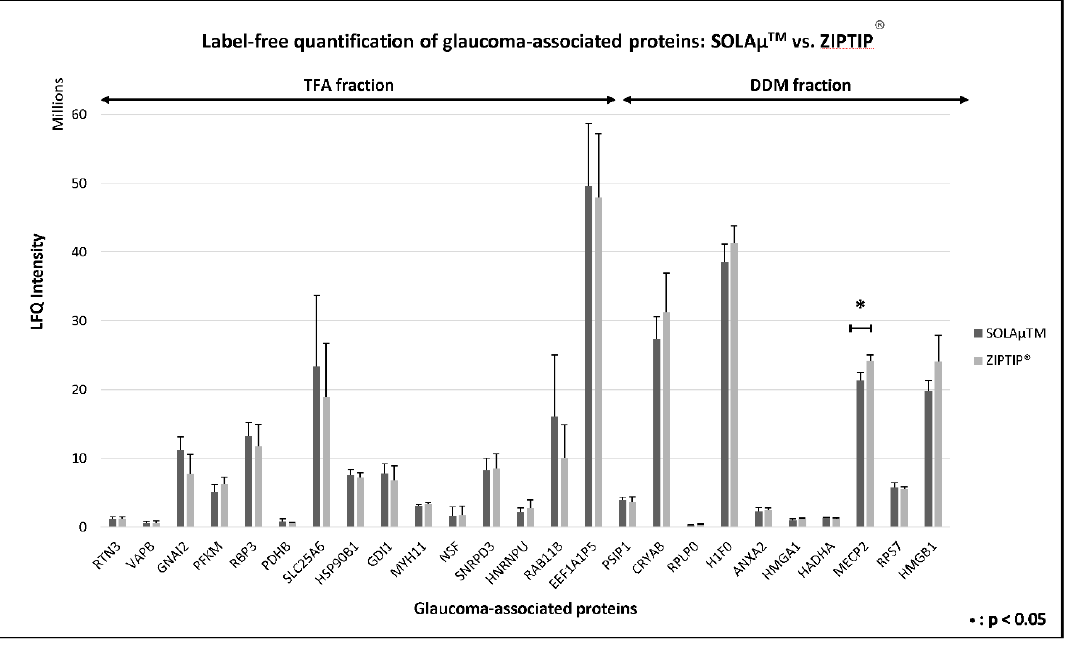
Figure 7. Bar plot shows the label-free quantification results of 25 glaucoma-associated biomarker candidates after enrichment with two different SPE purification methods (SOLA µ TM and ZIPTIP ® ). Marker candidates on the left were identified in the DDM fraction, whereas proteins on the right were detected in the TFA fraction (FDR < 1%). Only protein MECP2 showed a significant ( p < 0.05) higher abundance in ZIPTIP ® -purified replicates in comparison to SOLA µ TM -purified study samples.